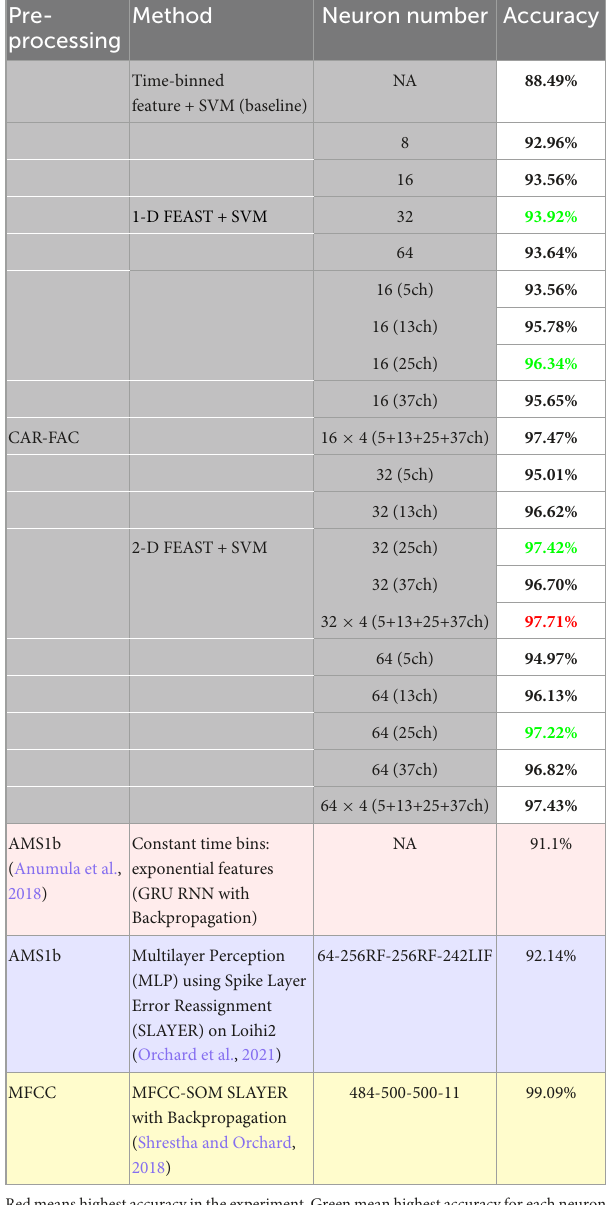
TABLE 2 Summary of investigated features on the TIDIGITS dataset. Pre- processing